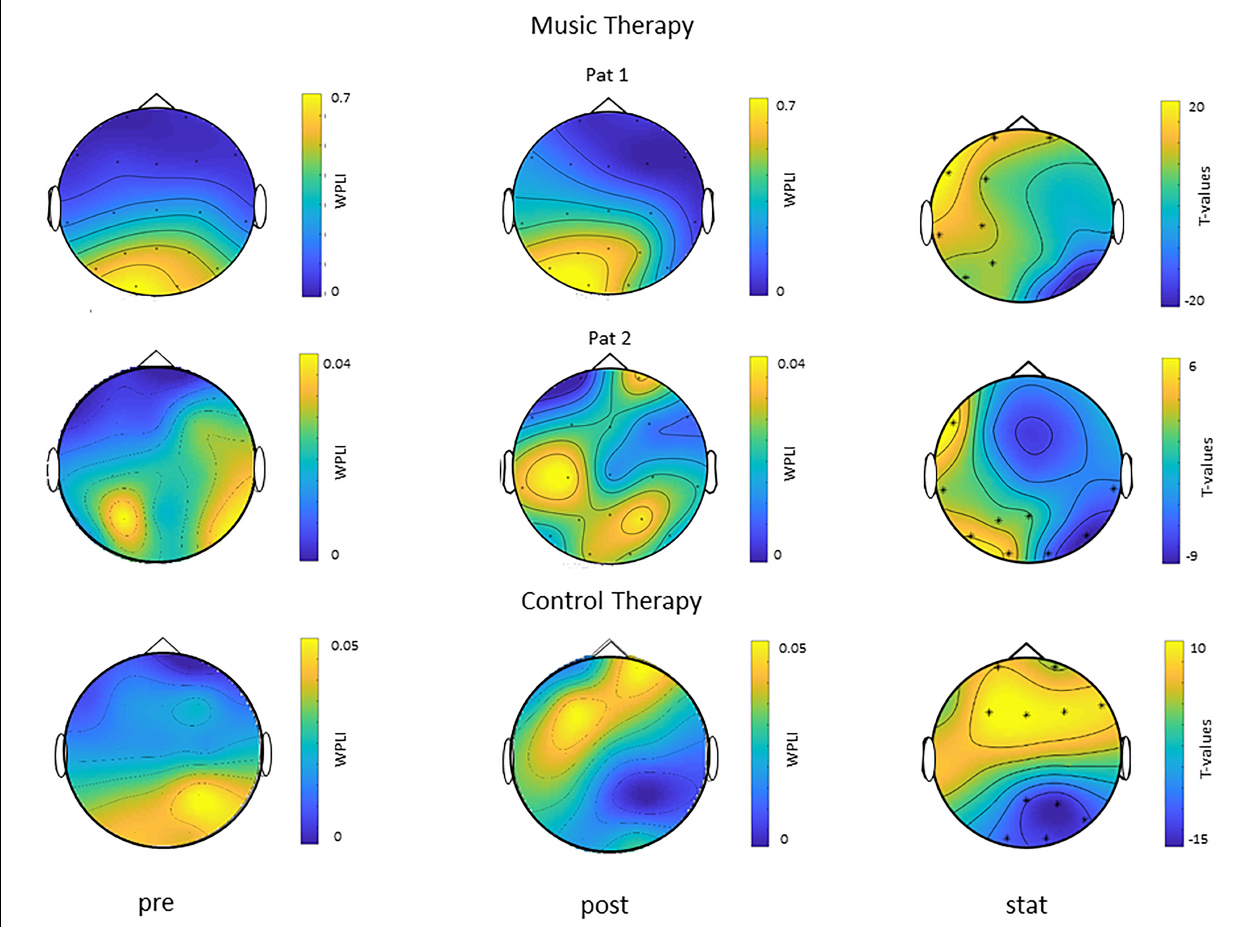
FIGURE 6 | Modulation of cortico-muscular phase coherence during movement of the paretic arm (single subject data). Topoplots of WPLI as a measure of cortico-muscular phase coherence before (pre) and after (post) therapy in two patients with music therapy (Pat 1 and Pat 2, both left hemispheric stroke, right arm trained, upper two rows) and one patient with control therapy (right hemispheric stroke, left arm trained, lower row) are shown in the left and middle column, respectively. T-statistic maps (stat) of cluster-based analyses of differences in WPLI post vs. pre therapy are shown in the right column. Channels belonging to significant clusters are marked with asterisks. Note left hemispheric (i.e., ipsilesional) cortico-muscular phase coherence increases during movements of the paretic right arm in the two patients with music therapy, while the patient with control therapy showed a rather bilateral topography of cortico-muscular phase coherence modulations during movements of the paretic left